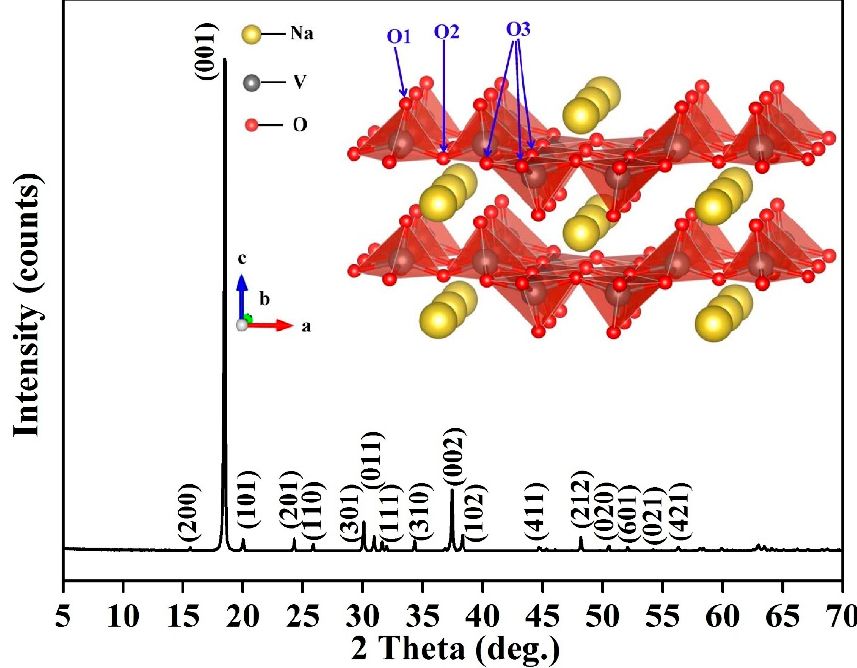
Figure 11. X-ray diffraction (XRD) pattern of the as-obtained NaV 2 O 5 . Figure 11. X-ray di ff raction (XRD) pattern of the as-obtained NaV 2 O 5 .